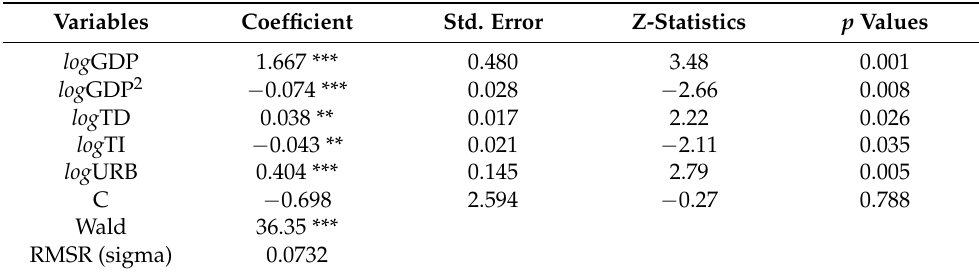
Table 8. Augmented Mean Group (AMG) test results.